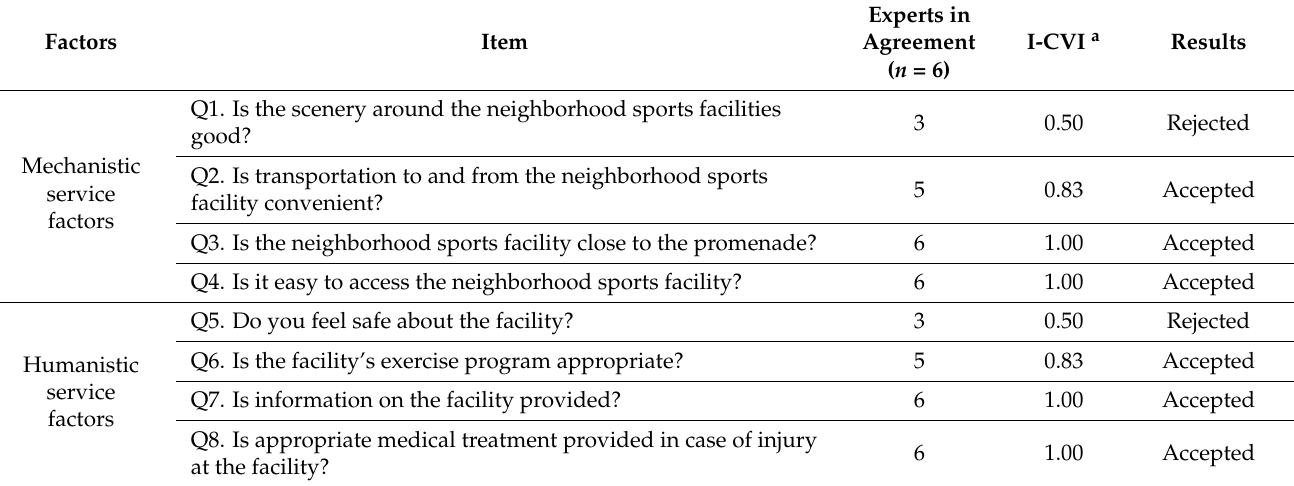
Table 2. Ratings of item relevance of six